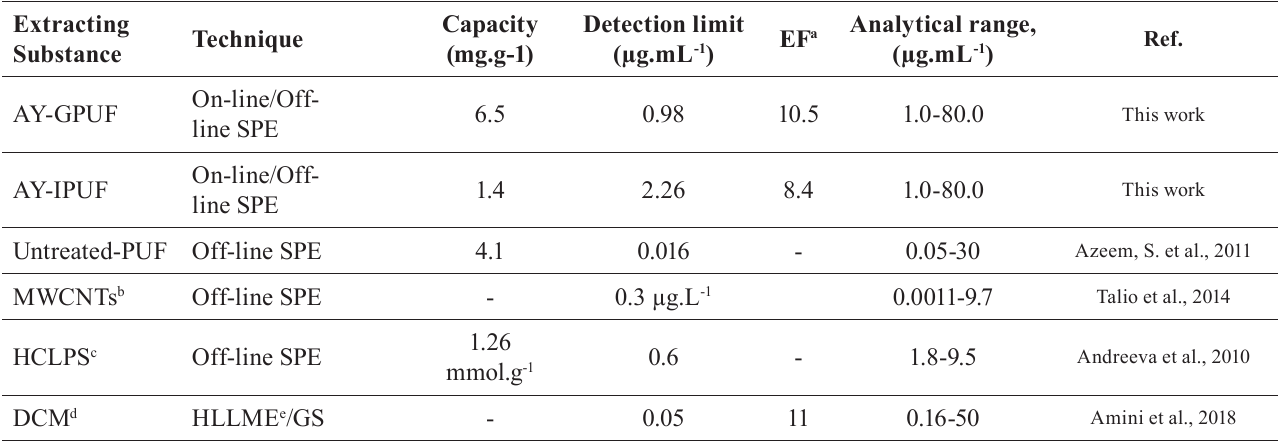
Table VII - Comparison of the analytical performance of the AY-GPUF and AY-IPUF sorbents to other reported methods for preconcentration and determination of